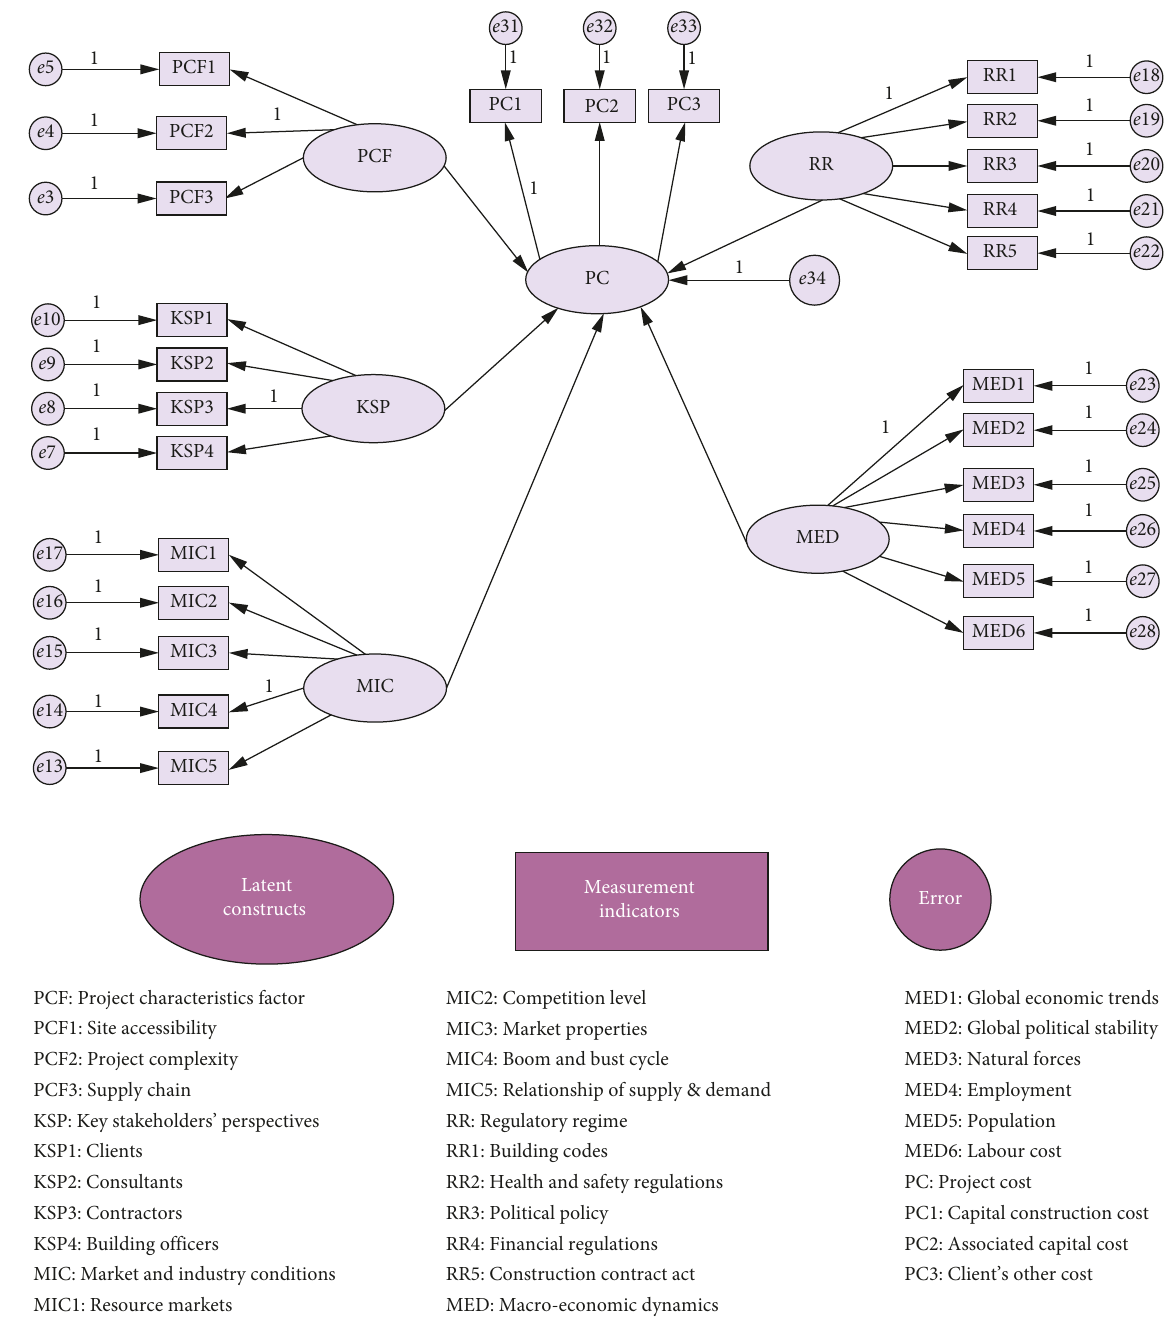
Figure 2: The final research